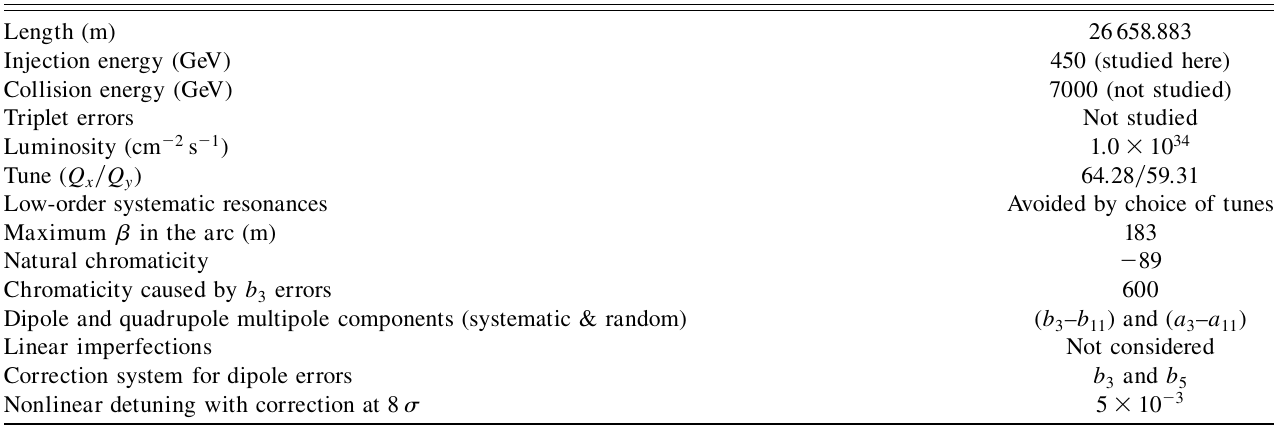
TABLE IV. LHC parameters.